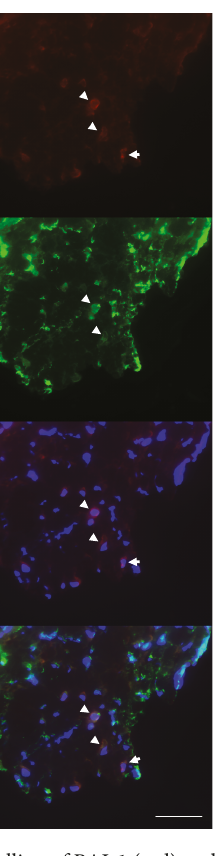
Figure 8: Double-labelling of PAI-1 (red) and α -SMA (green) in an irradiated vein. Arrowheads indicate colocalization of PAI-1 and α - SMA, indicating expression of PAI-1 in myo fi broblasts. Arrows indicate cells with PAI-1 expression but no α -SMA expression. Nuclear stain (DAPI) is shown in blue (scale bar =50 μ